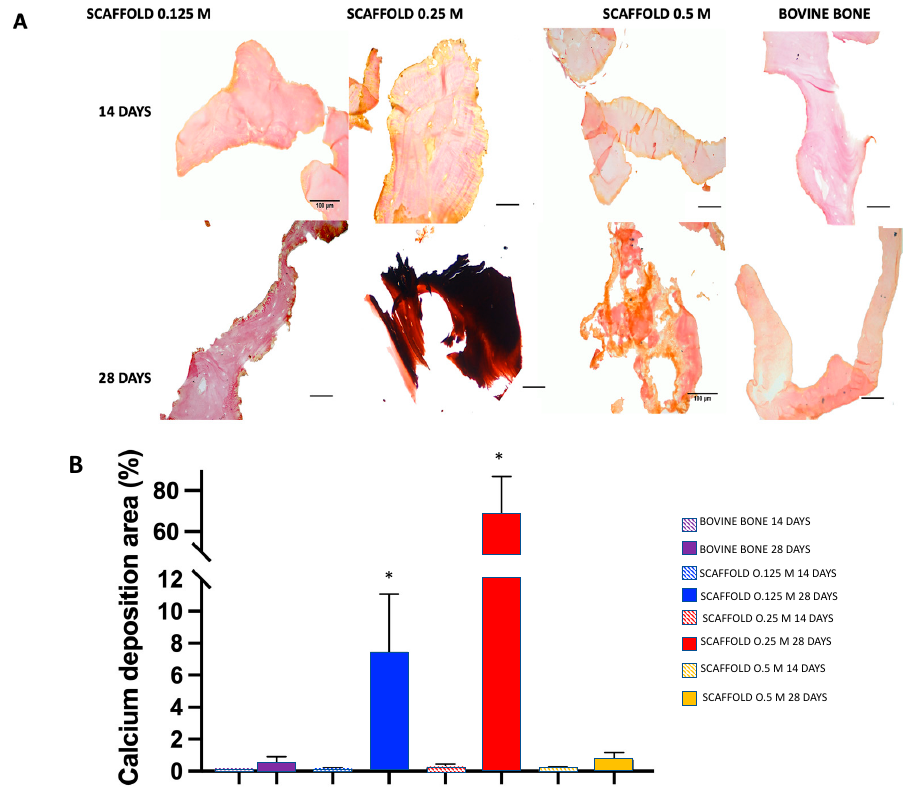
Figure 13. ( A ) Detection of mineral deposit visualized by von Kossa staining in histological sections: collagen (pink), osteoid (red), calcium (black). Optical microscope photomicrographs of histologically stained sections with von Kossa at 40× magnification. We used the visualization of calcium deposits, stained with the von Kossa technique, as an indicator of differentiation of the hWJ-MSCs cultured on the scaffolds without a mineralization-inducing medium. As a control, we used decalcified bovine bone. ( B ) The quantification of calcium deposit area in von Kossa staining calculated by Image-Pro software demonstrates that the 0.125 M and 0.25 M scaffolds showed a substantial deposit of calcium phosphate after 28 days of culture in the absence of mineralization-inducing medium compared to all groups * p < 0.0001. Mean + SD n > 3. 40 × , scale bar = 100 µ